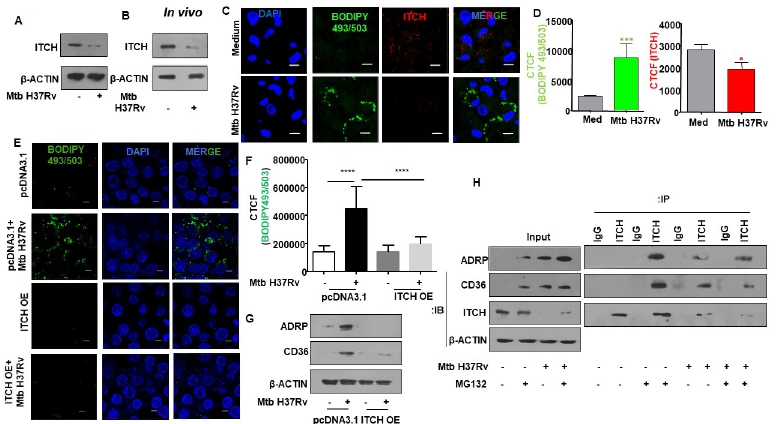
Fig 1. E3 ubiquitin ligase ITCH (AIP4) repression aids in Mtb-mediated enhanced lipid accumulation. (A) Mouse peritoneal macrophages were infected with Mtb H37Rv for 24 h. Whole cell lysates were assessed for ITCH protein expression by immunoblotting. (B) BALB/c mice were aerosol-infected with Mtb H37Rv for 28 days. Protein levels of ITCH was analyzed in the lung homogenates of uninfected and infected mice by immunoblotting. (C, D) Mouse peritoneal macrophages were infected with Mtb H37Rv for 48 h and assessed for lipid accumulation (BODIPY493/ 503) and ITCH expression by immunofluorescence microscopy; (C) representative image and (D) respective quantification. (E, F) RAW 264.7 cells were transfected with pcDNA3.1 and ITCH OE vectors. Transfected cells were infected with Mtb H37Rv for 48 h and assessed for the accumulation of lipids by fluorescence microscopy (BODIPY493/503); (E) representative image and (F) respective quantification. (G) RAW 264.7 cells were transfected with pcDNA3.1 and ITCH OE vectors; Transfected cells were infected with Mtb H37Rv for 24 h and whole cell lysates were assessed for the levels of the indicated lipid accumulation markers by immunoblotting. (H) Mouse peritoneal macrophages were infected with Mtb H37Rv for 24 h and treated with MG132 for the last 4 h of infection. Whole cell lysates were immunoprecipitated with IgG control or ITCH antibodies and assessed for their interaction with the indicated lipid accumulation markers by immunoblotting. All immunoblotting and immunofluorescence data are representative of three independent experiments. Lung homogenates from at least three mice were independently assessed for ITCH expression by immunoblotting. β -ACTIN was utilized as loading control. Med, medium; OE, over expression; CTCF, corrected total cell fluorescence. � , p < 0.05; ��� p < 0.001; ���� , p < 0.0001 (Student’s t-test in D, One way ANOVA in F; GraphPad Prism 6.0). Scale bar, 5 μ m.